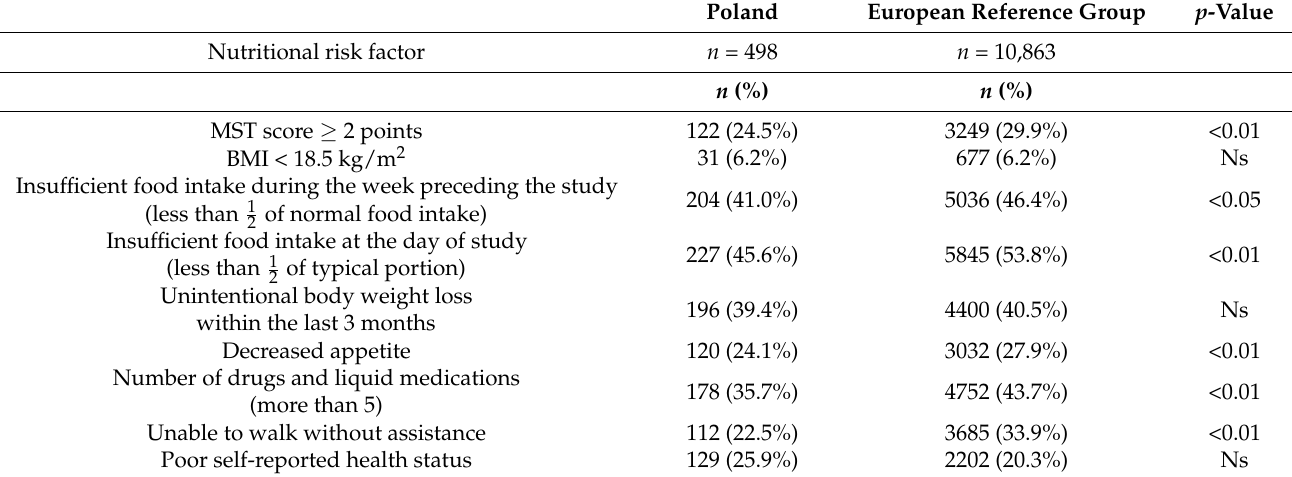
Table 4. Prevalence of nutritional risk factors.